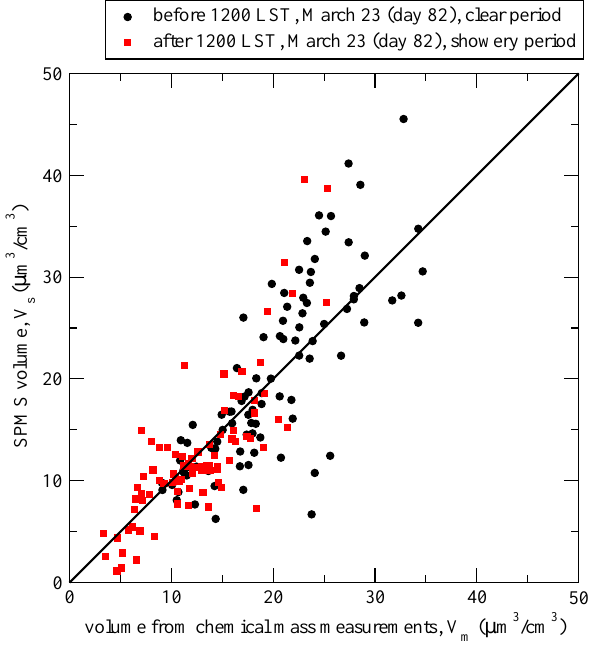
Fig. 4. Scatterplot of aerosol volumes derived from the chemical mass measurements, or the size distribution measurements (and ex- trapolation, see